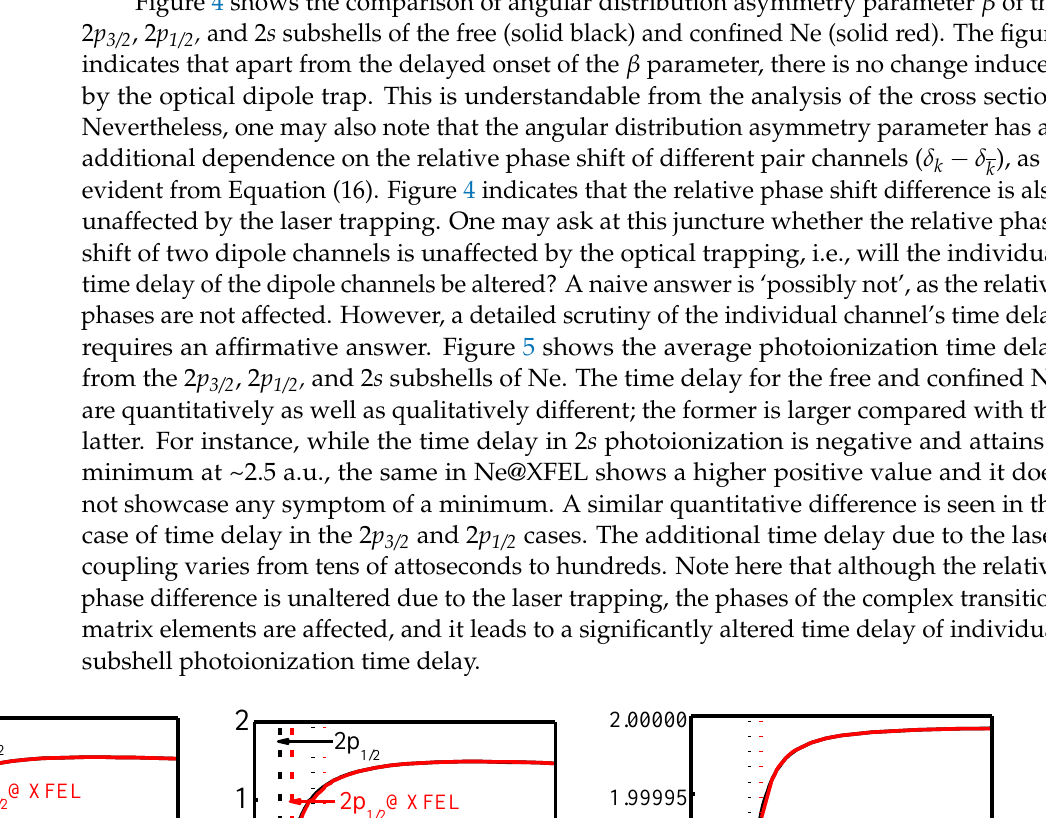
Figure 3. Photoionization cross section (σ) of 2p 3/2 (Left), 2p 1/2 (Middle), and 2s (Right) subshells of Ne (black) and Ne@XFEL (red). Solid, dashed, and dotted vertical lines represent the threshold for 2p 3/2 , 2p 1/2 , and 2s thresholds of free (black) and confined atom (red), respectively.